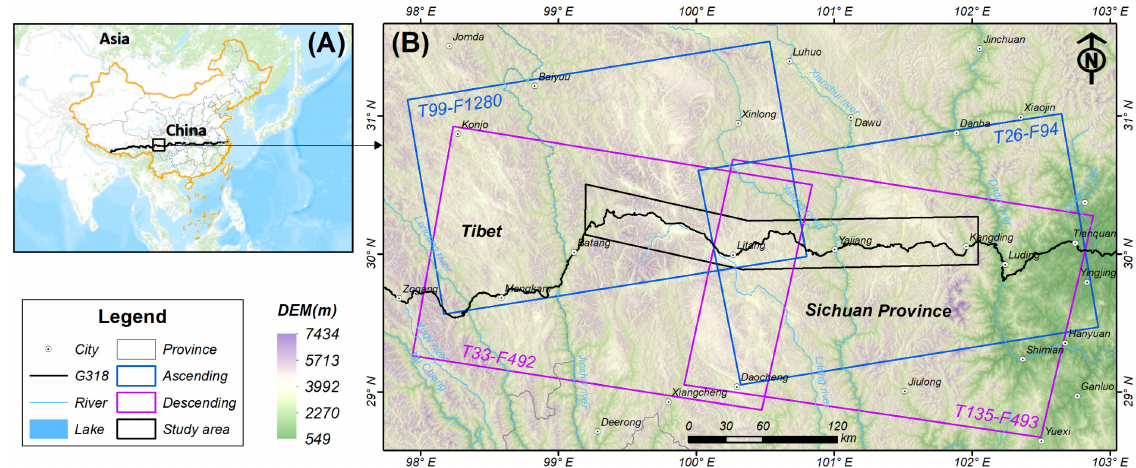
Figure 1. Overview of the study area. ( A ) Location of the G318 and the study area; ( B ) topographic map of the study area. The purple and blue rectangles outline the coverage of the Sentinel-1 SAR images. The black polygon shows the extent of the study area.